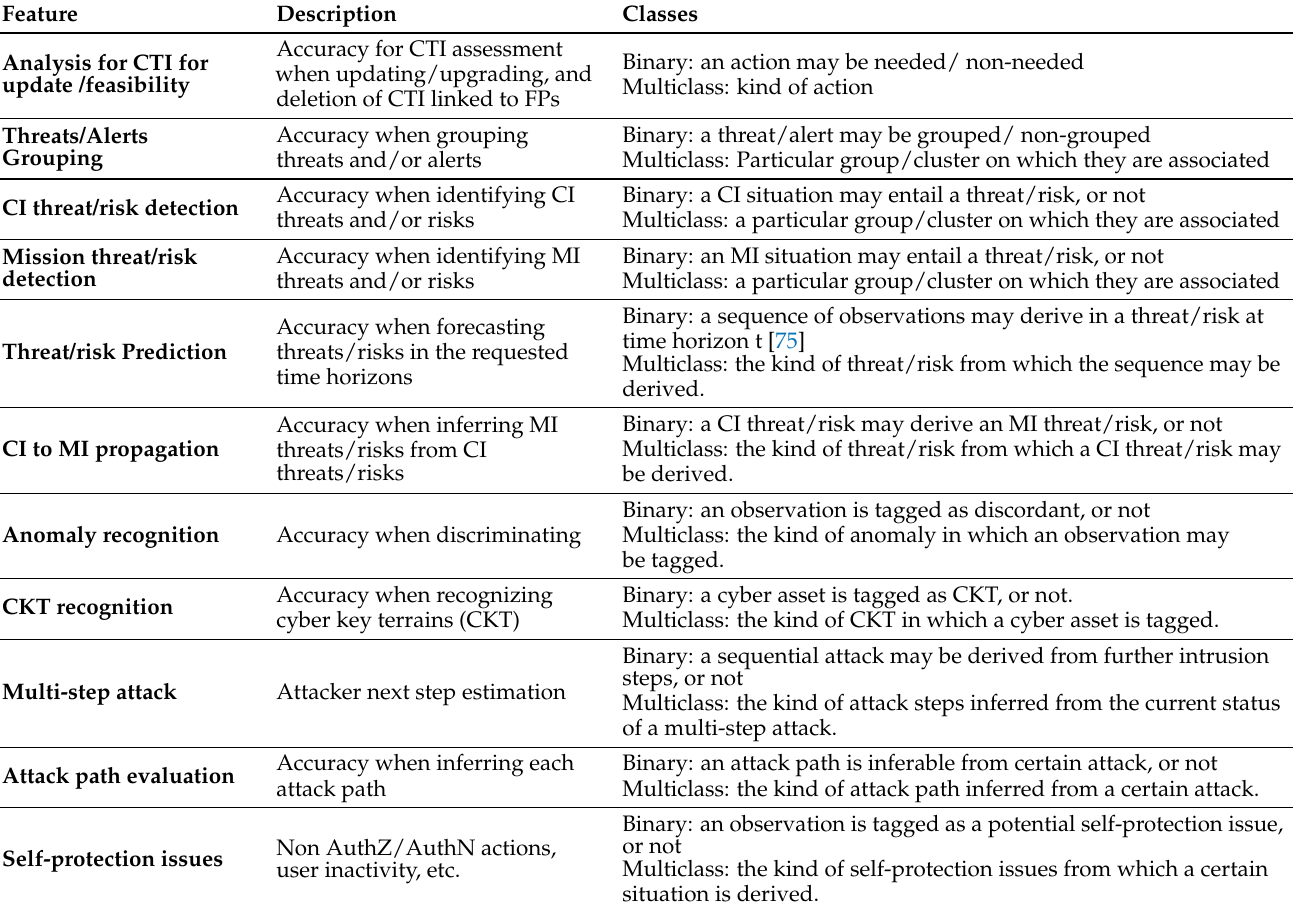
Table 1. Accuracy: illustrative deconstruction of observation in